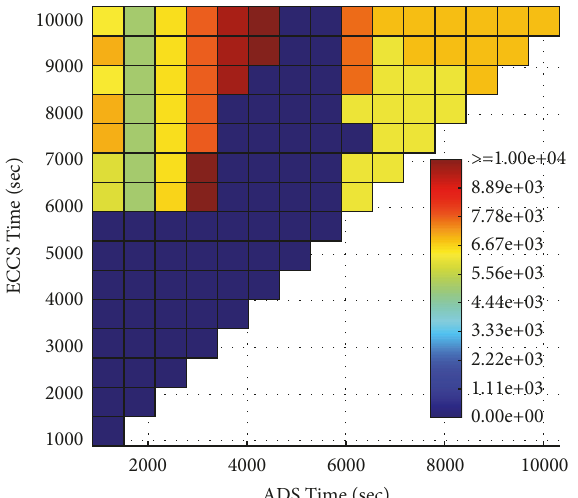
Figure 12: The time of the coresupport platefailure 𝑇 𝑟𝑒𝑓 (sec) predicted by MELCOR 2.2 (with M1.86 default values of sensitivity coefficients).